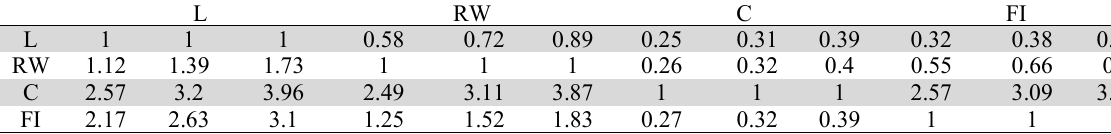
Aggregated fuzzy comparison matrix of criteria (Input)